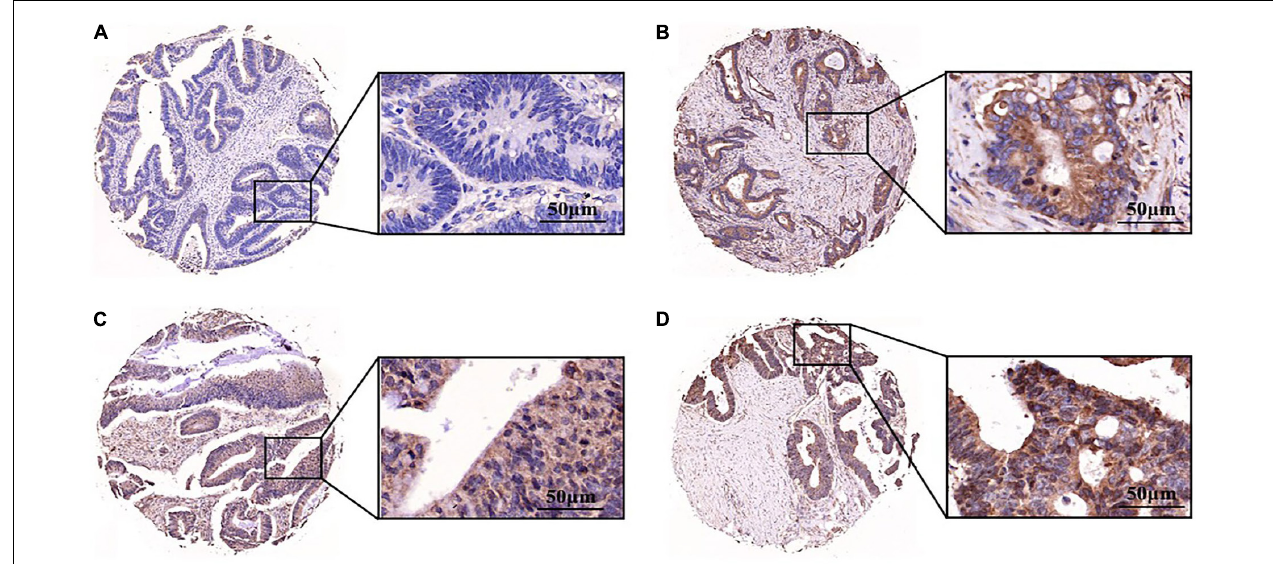
FIGURE 6 | Aurora A was highly expressed in colorectal adenocarcinoma. Expression pattern of Aurora kinase A in tissue microarray cores of colorectal adenocarcinoma. The staining intensity of the nuclei was evaluated as (A) negative, (B) weak, (C) moderate or (D) strong (scale bar = 50 µ m). The data are presented for at least three independent